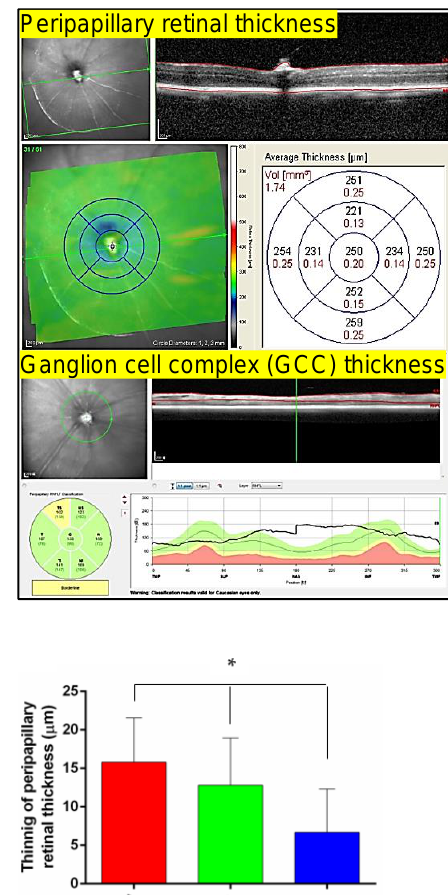
(STZ) injection. ( D ) Diabetic mice treated with 20 mg/kg PGZ for 2 weeks had a lower level of blood sugar than those treated with 10 and 0 mg/kg PGZ (* p < 0.05).